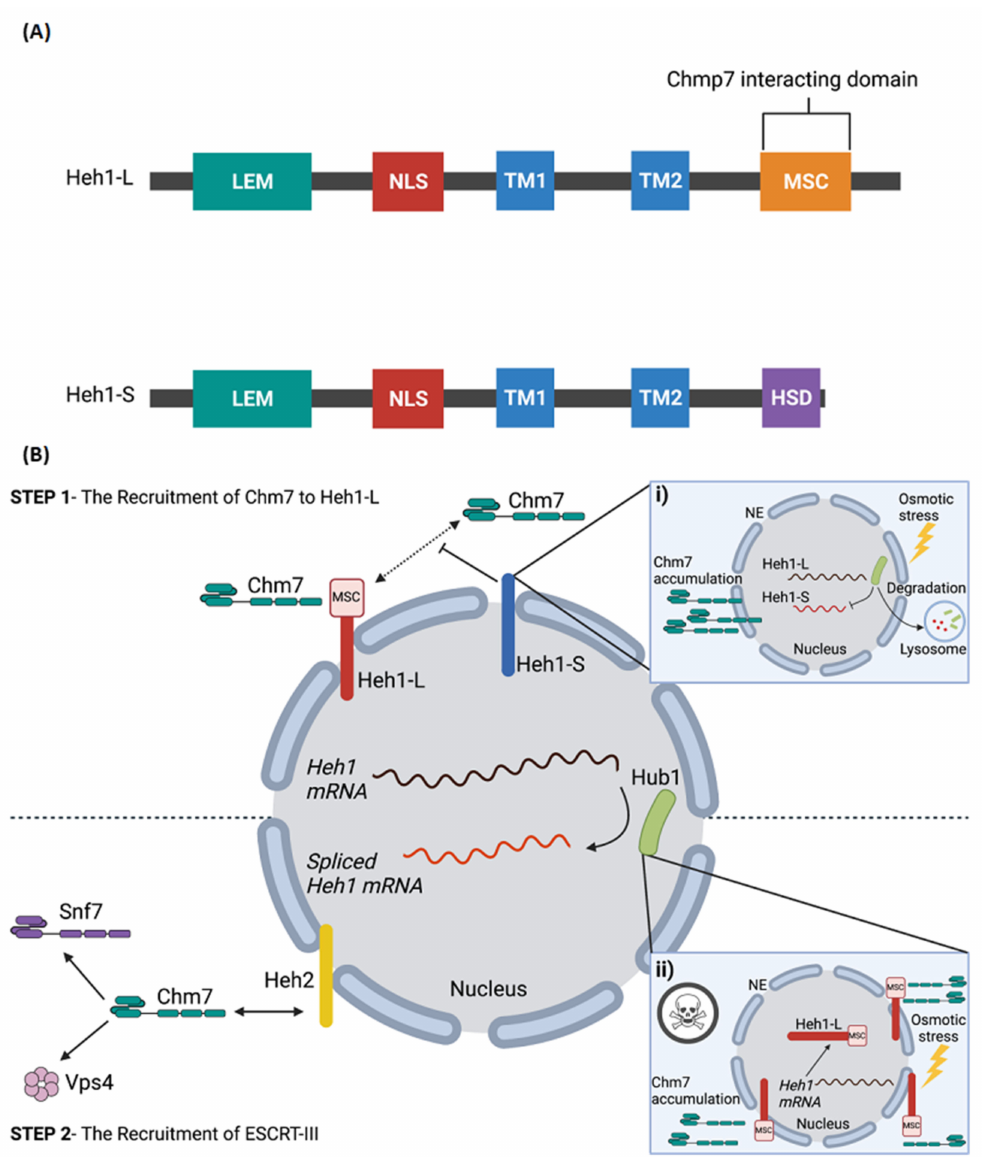
Figure 2. Alternative splicing of Heh1 regulates Chm7 recruitment to NPC assembly sites. ( A ) The domain architecture of Heh1-L and Heh1-S [87]. Alternative splicing of Heh1 results in two variants: a long form (Heh1-L) and a short form (Heh1-S). The splicing events causes a shift in the open reading frame of Heh1-S that results in the deletion TM2 and the C-terminal MSC domain (Chm7 interacting domain), and the addition of the Heh1-S specific domain (HSD). ( B ) Heh1-L recruits Chm7 through its MSC domain (Step 1); after which Chm7 directly interacts with Heh2 to recruit downstream factors that promote ESCRT-III assembly, including Snf2 and Vps4, to facilitate NPC turnover (Step 2). In contrast, Heh1-S inhibits the recruitment of Chm7 as a result of the missing C-terminal MSC domain (i). This balance of Heh1 splice isoforms is regulated during heavy metal and oxidative cell stress to regulate the accumulation and retention of Chm7 at the nuclear envelope. However, under osmotic stress, Hub1 is exported out of the nucleus and degraded, an event that inhibits alternatively splicing of Heh1 and resulting in only Heh1-L being expressed. In the absence of Heh1-S and expression of Heh1-L alone, Chmp7 is excessively recruited to the nuclear envelope which is toxic to the cell (ii). Created with